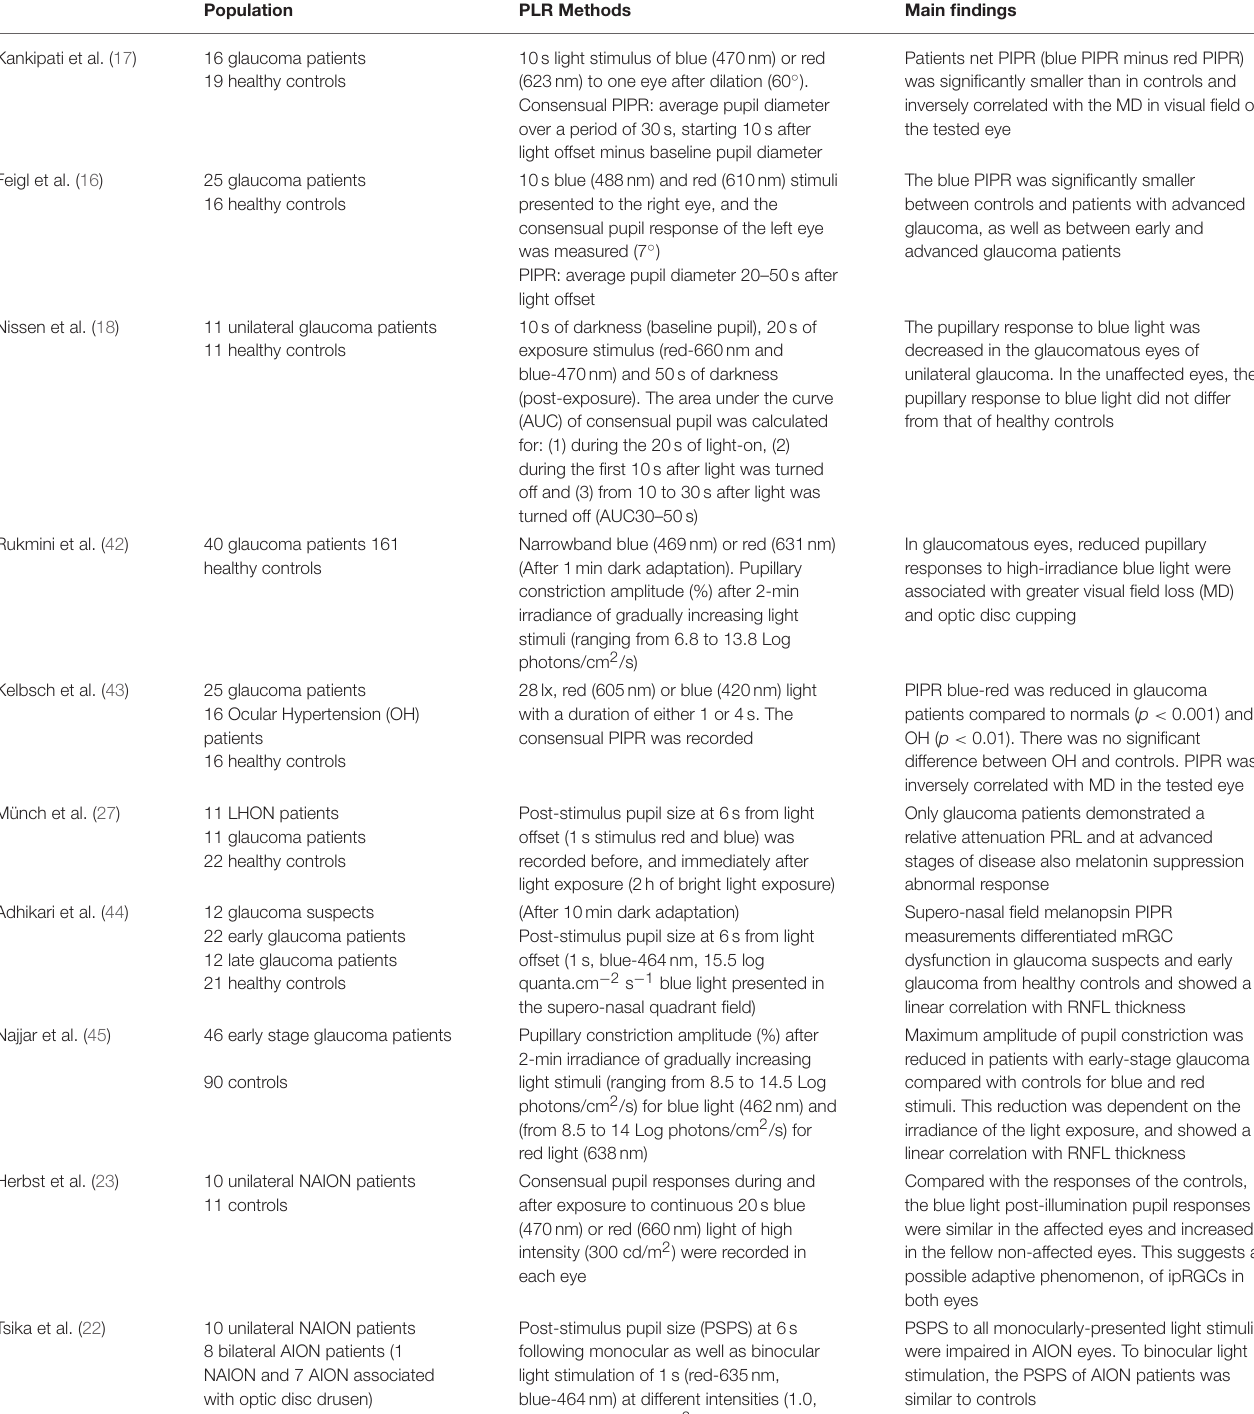
TABLE 1 | Pupillometry findings in glaucoma and in anterior ischemic optic